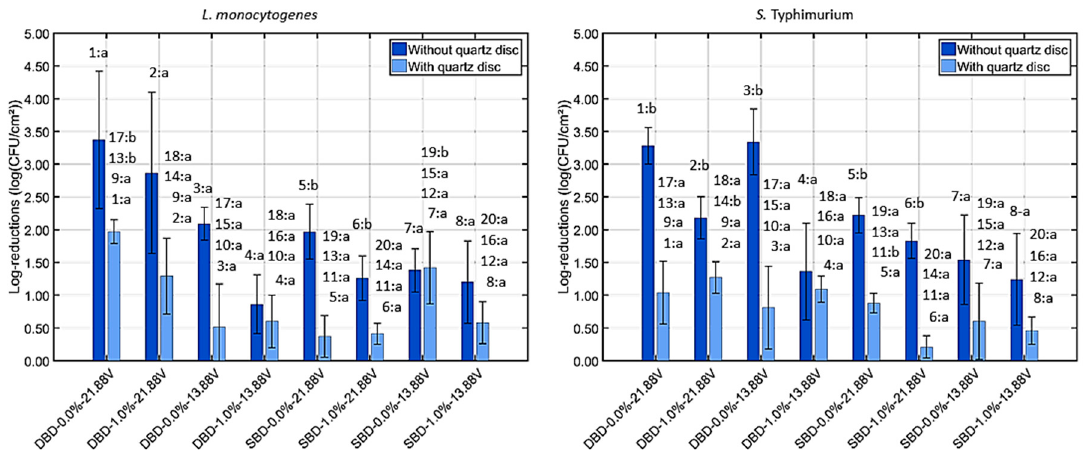
Figure 6. Log-reductions (log 10 (CFU/cm²)) obtained following CAP treatment of the model biofilms using each possible combination of plasma characteristics ( n = 2). Log-reductions with quartz disc were compared with those previously obtained without quartz disc [17] to comment on the contribution of UV light to the inactivation efficacy of the CAP treatment. Significant differences between the log-reductions obtained with and without quartz disc while applying the same treatment conditions (ANOVA tests 1–8) have been indicated by means of a different small letter, with ‘a’ bearing the lowest value. ANOVA tests 9–12, 13–16, and 17–20 were, respectively, performed to examine whether the oxygen level, the electrode configuration, and the discharge power had a significant influence on the log-reduction values obtained with implementation of the quartz disc. For each of these tests, one plasma characteristic was altered while keeping the other characteristics constant. Significant differences were again indicated by means of a different small letter, with ‘a’ again bearing the lowest value. Moreover, separate ANOVA tests were performed for each biofilm forming species.